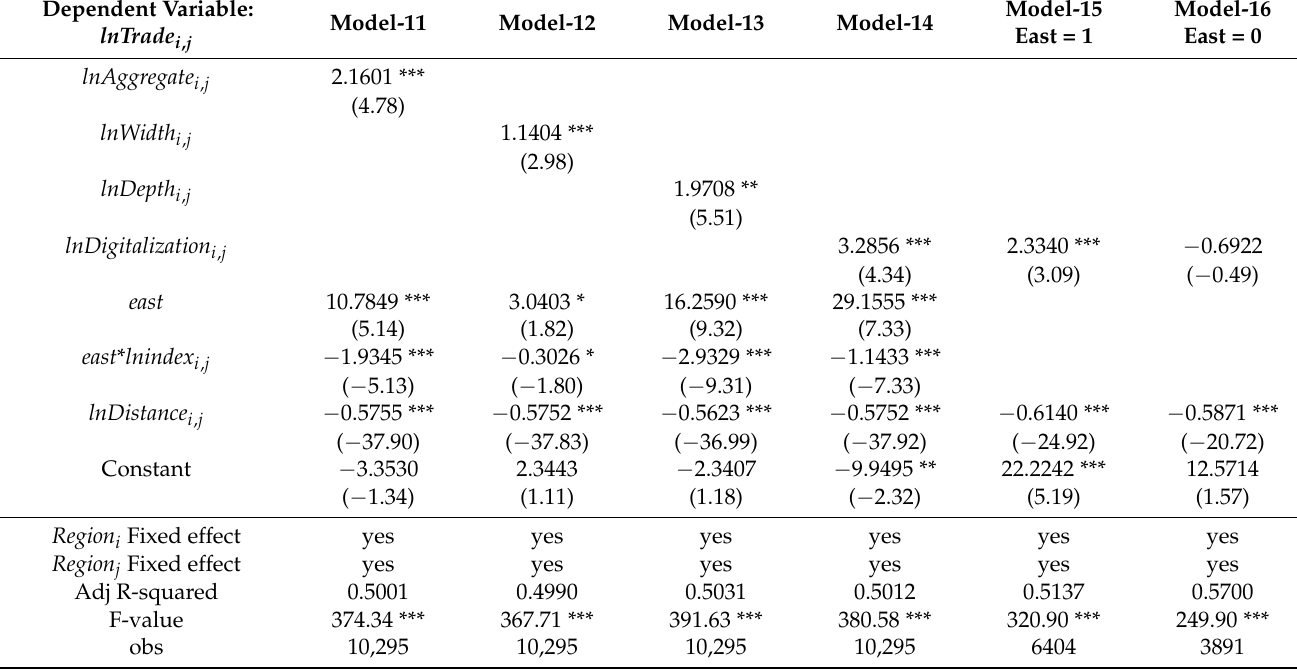
Table 5. Results of regional heterogeneity estimated by the LL-FE